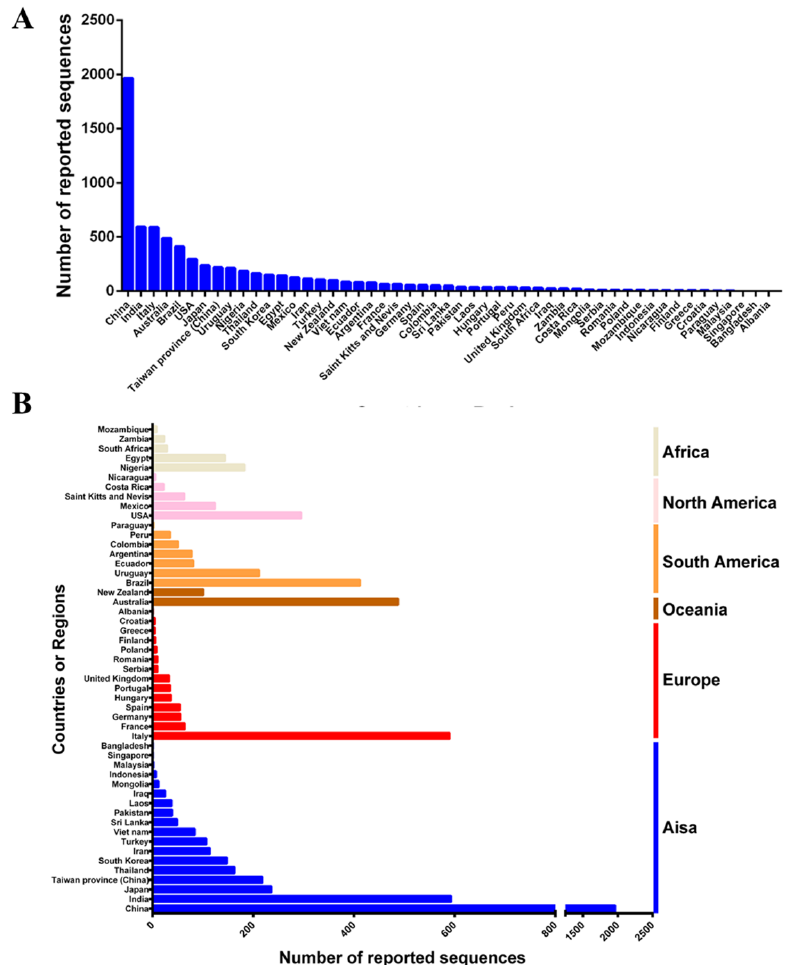
Figure 1. Distribution of the number of CPV-2 strains in different countries or regions: ( A ) sorted according to the number, ( B ) sorted according to the continent classification of the country or region.